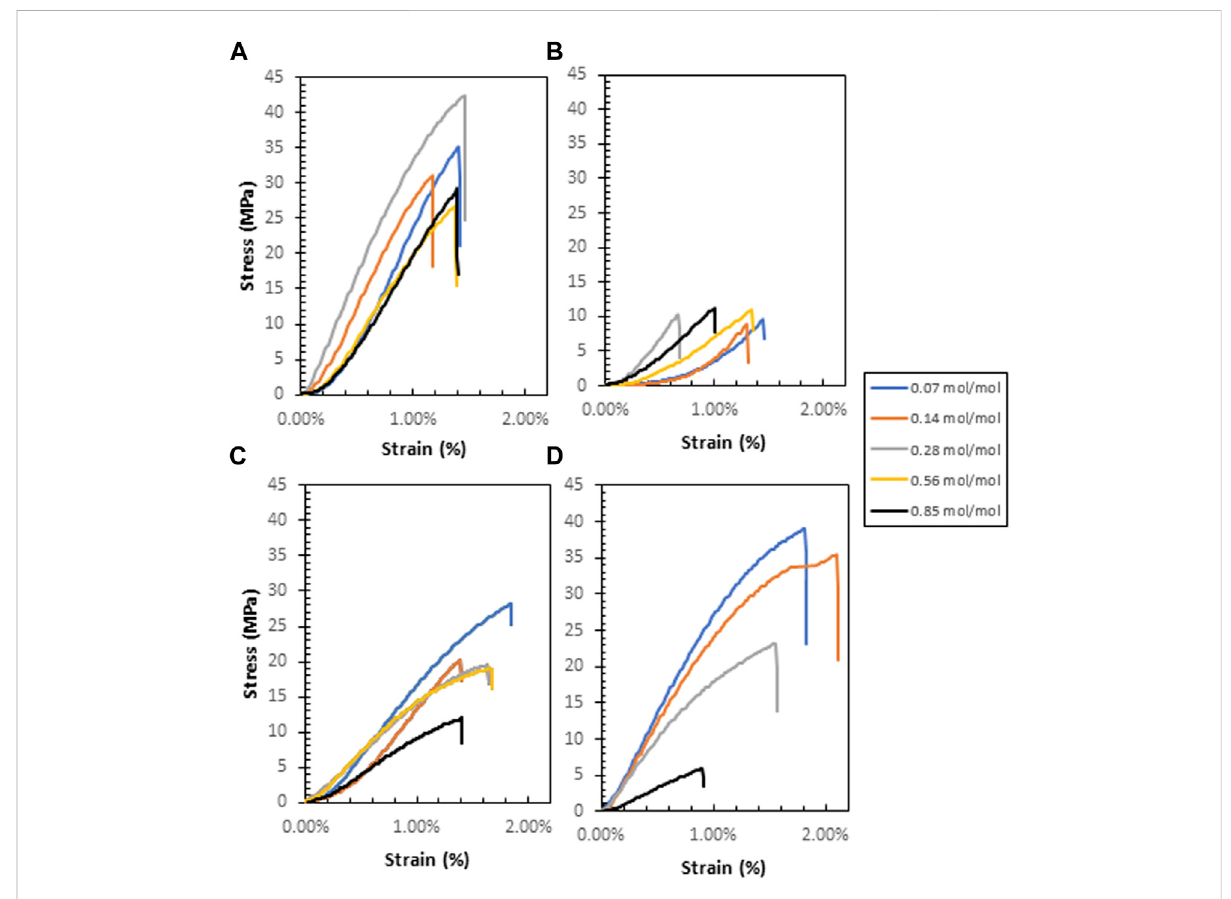
FIGURE 8 Nominal stress-strain curves for each polymer: (A) — G-CMC, (B) — PPG (380)-CMC, (C) — PEG-CMC, (D) — PPG